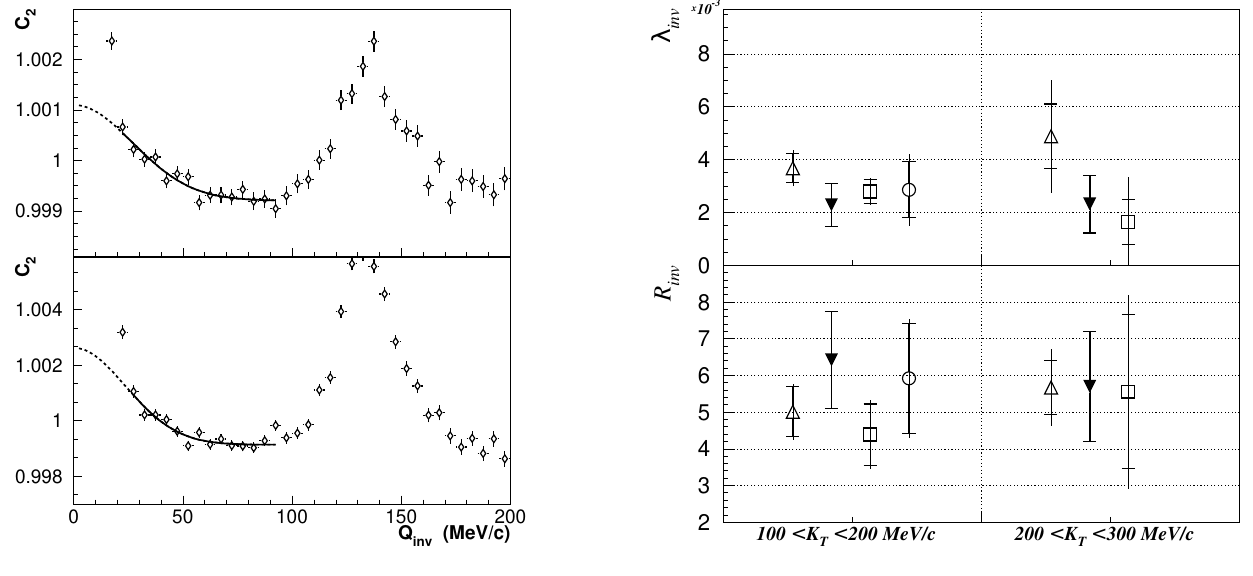
Figure 7. Left plot: the two-photon correlation function for average photon momenta 100 < K T < 200 MeV/ c (top) and 200 < K T < 300 MeV/ c (bottom) measured in 0–20% central 158 A GeV 208 Pb+ 208 Pb collisions and fitted with Equation (5) [13]. Right plot: Comparison of parameters of correlation functions measured with different particle identification criteria: —all clusters, (cid:72) — (cid:52) narrow electromagnetic, (cid:3) —all neutral, —narrow neutral electromagnetic (no significant result for (cid:13) high K T